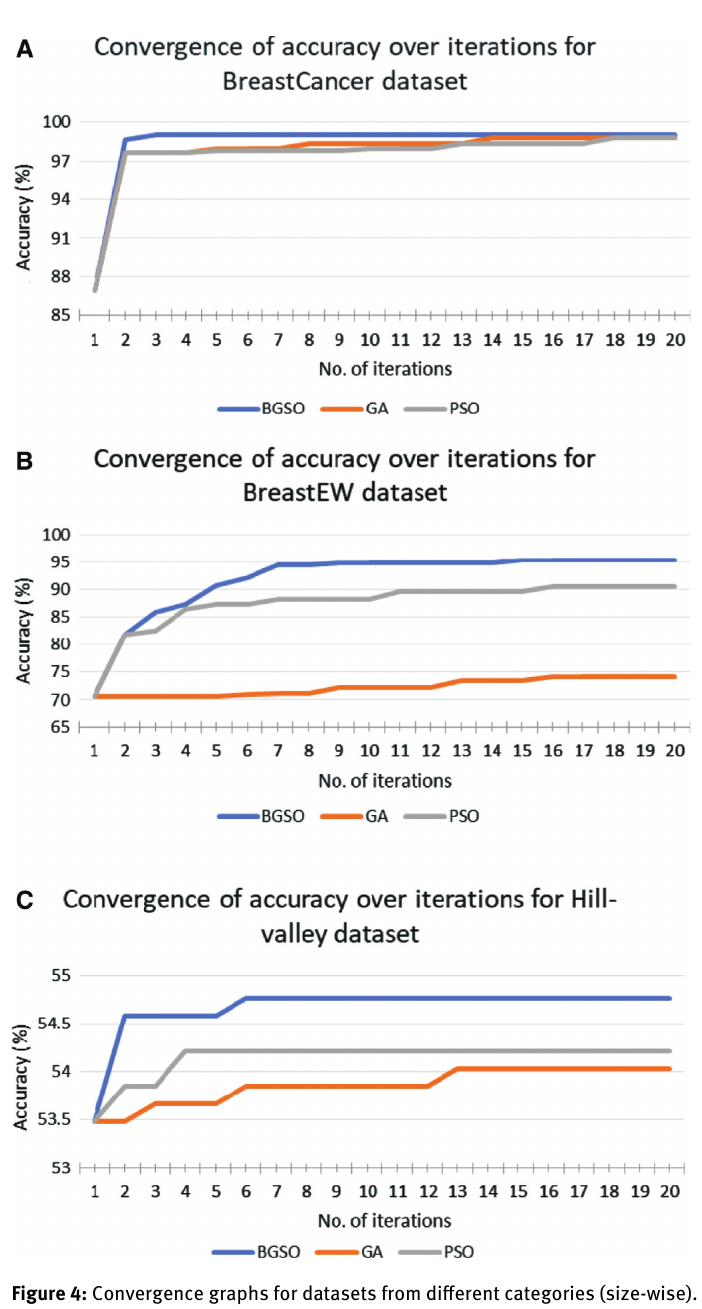
Figure 4: Convergence graphs for datasets from different categories (size-wise). Convergence graphs representing the changes of classification accuracies over iterations for BGSO and its constituent algorithms (GA and PSO) for the BreastCancer (A), BreastEW (B) and Hill-valley (C) datasets. The three datasets used in (A), (B) and (C) belong to three different categories namely small (BreastCancer), medium (BreastEW) and large (Hill-valley) to show the differences in convergence in terms of size of the